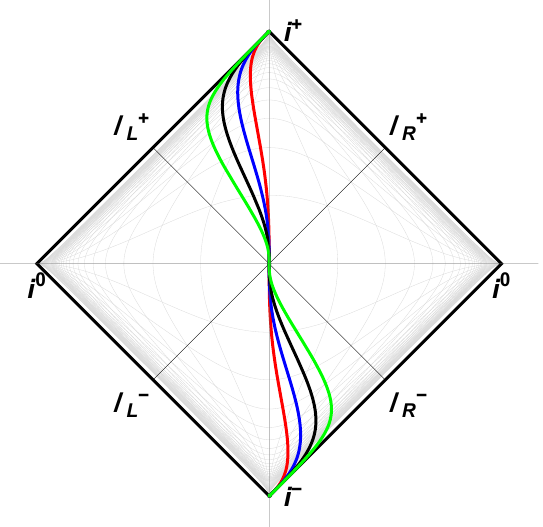
Figure 2. A Penrose diagram of the mirror trajectory, Equation (3). The mirror is moving at light- speed at v → ± ∞ . Since the acceleration is asymptotically zero as v → ± ∞ then this mirror is asymptotically inertial. The various colors correspond to different maximum accelerations; here κ = 1,4,16,64 from red, blue, black, and